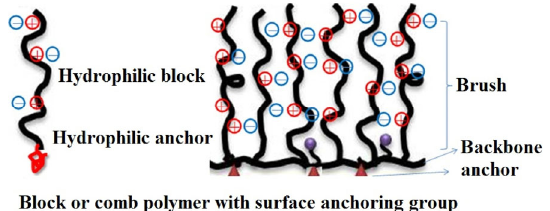
Fig. 8 Structures of hydrophilic polymers with surface anchoring